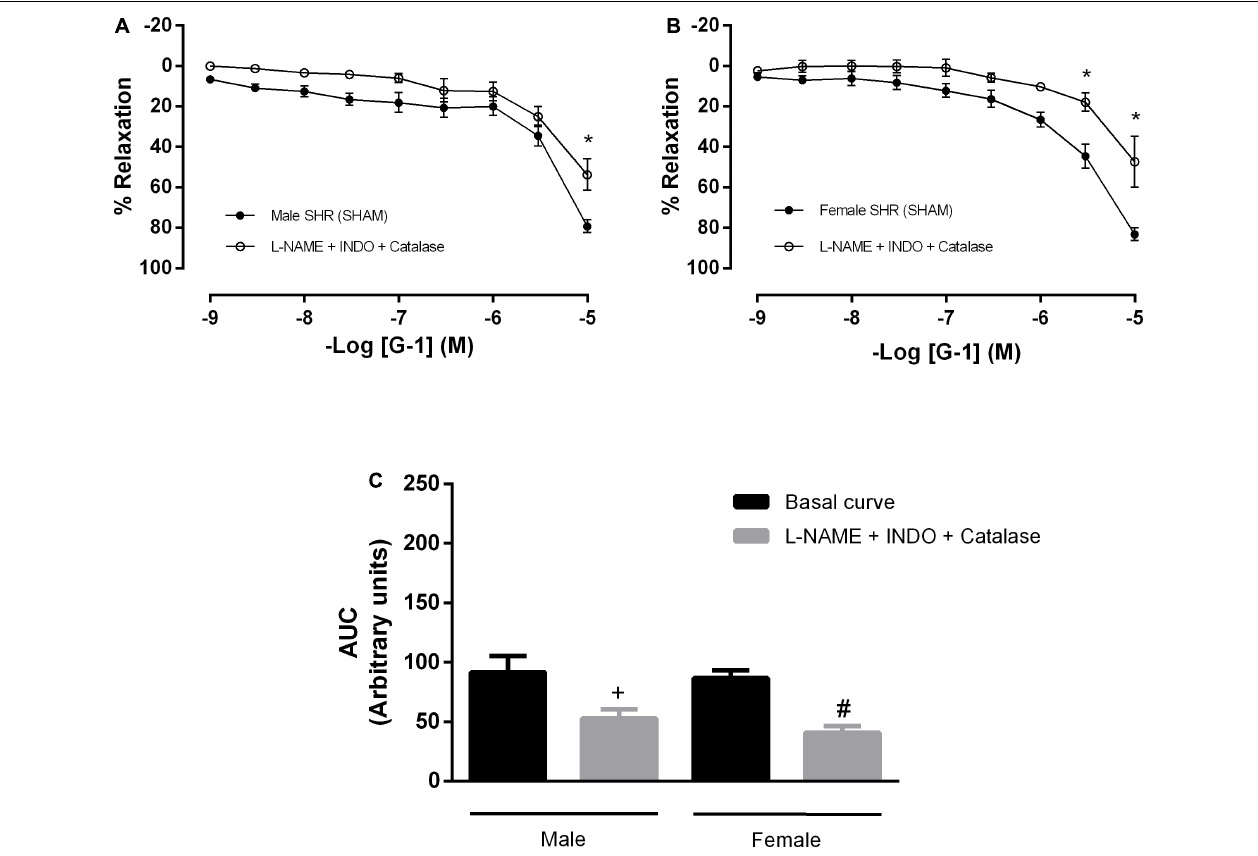
FIGURE 7 | Hydrogen peroxide (H 2 O 2 ), another pathway of endothelium-dependent hyperpolarization, participates in the vasodilator response induced by G-1 in both sexes. Effect of non-selective nitric oxide synthase inhibition with N ω -nitro-L-arginine methyl ester (L-NAME, 300 µ M), cyclooxygenase inhibition with indomethacin (INDO, 10 µ M) and an enzyme that specifically decomposes H 2 O 2 (Catalase, 1000 units/mL) in (A) Male ( n = 6) and (B) Female ( n = 4) SHR groups. (C) Area under the curve (AUC) before and after L-NAME, INDO, and catalase incubation. Values are expressed as mean ± SEM. * P < 0.05 compared to the same dose in the control curve, + P < 0.05 compared to the AUC of the Male SHR control curve and # P < 0.05 compared to the AUC of the Female SHR control curve. The curve analysis was carried out point-by-point through two-way ANOVA, followed by the Sidak post hoc test. AUCs were evaluated through one-way ANOVA followed by Tukey post hoc